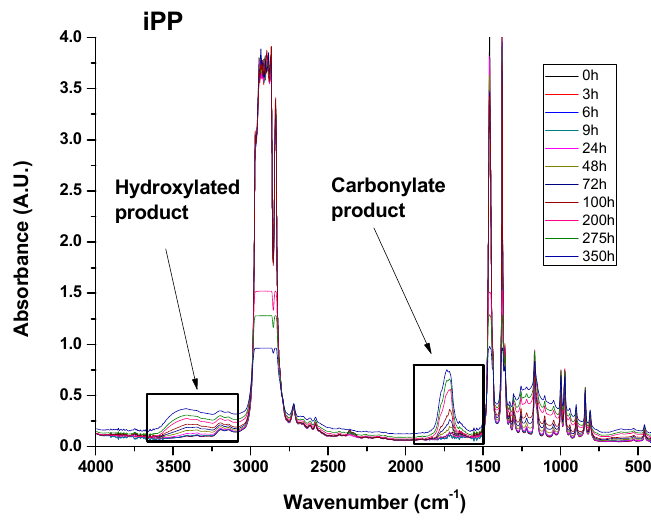
Figure 13. FT/IR spectra of sample A unirradiated and exposed at increasing UV irradiation times.